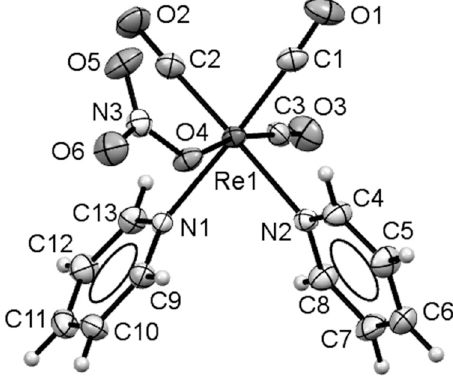
Table  : Data collection and handling.